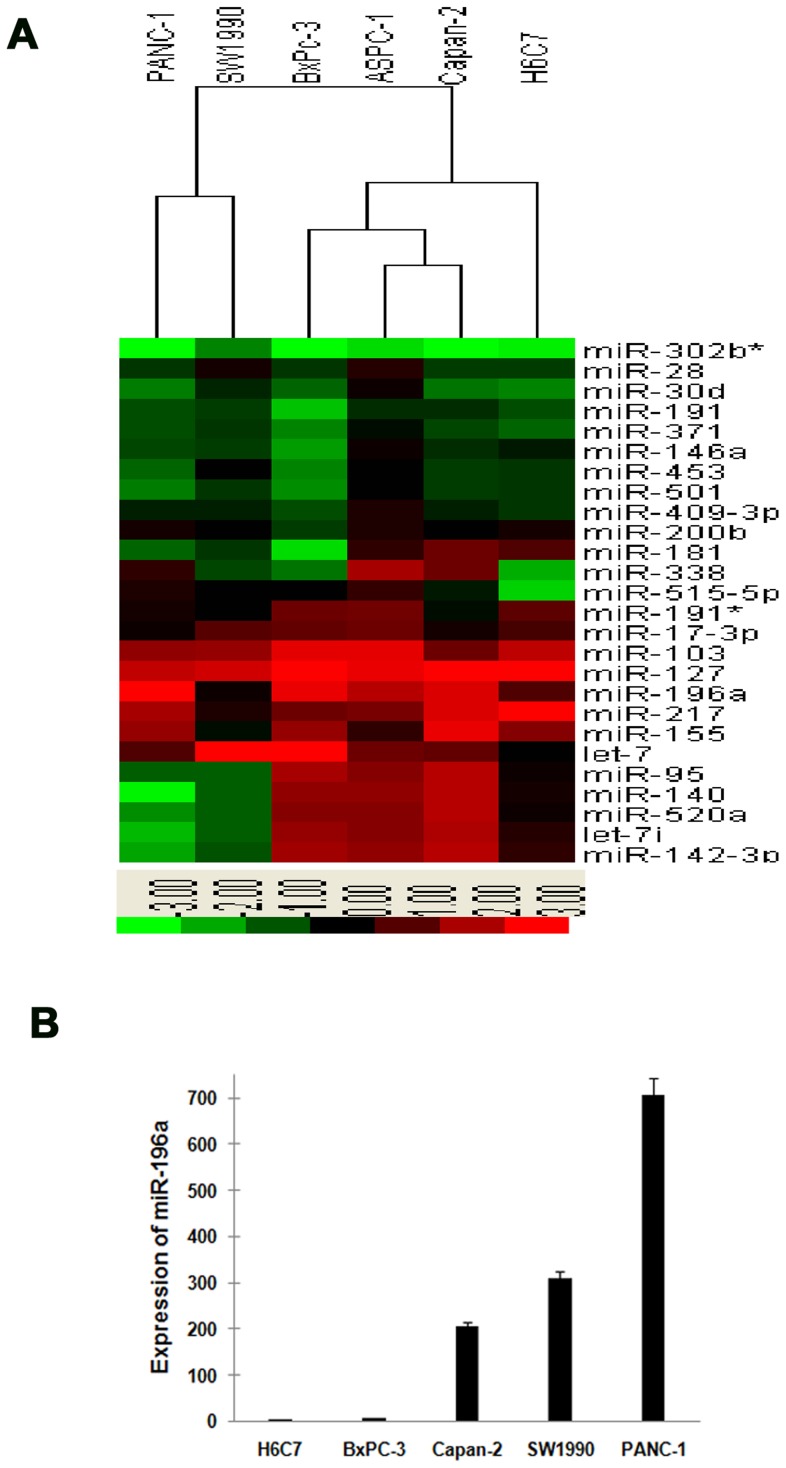
MiR-196a was overexpressed in pancreatic cancer cell lines.(A) Hierarchical clustering analysis of miRNAs that were either differentially up- or downregulated in pancreatic cancer cell lines and H6C7. MiRNAs that scored a differential value of 1 or greater were categorized as differentially upregulated, and miRNAs that scored a value of −1 or less were categorized as differentially downregulated. The scale bar across the bottom of the heatmap depicts SD change from the mean. MiR-196a expression was significantly higher in pancreatic cancer cell lines in microarray. (B) Validation of miR-196a expression level in pancreatic cancer cell lines by qRT-PCR. MiR-196a was significantly upregulated in pancreatic cancer cell lines. Expression of miR-196a was (706.4±9.4)-fold in PANC-1 cells, (310.1±7.5)-fold in SW1990 cells, (7.6±1.1)-fold in BxPC-3 cells and (204.9±4.8)-fold in Capan-2 cells, compared with H6C7 (*, P<0.05).